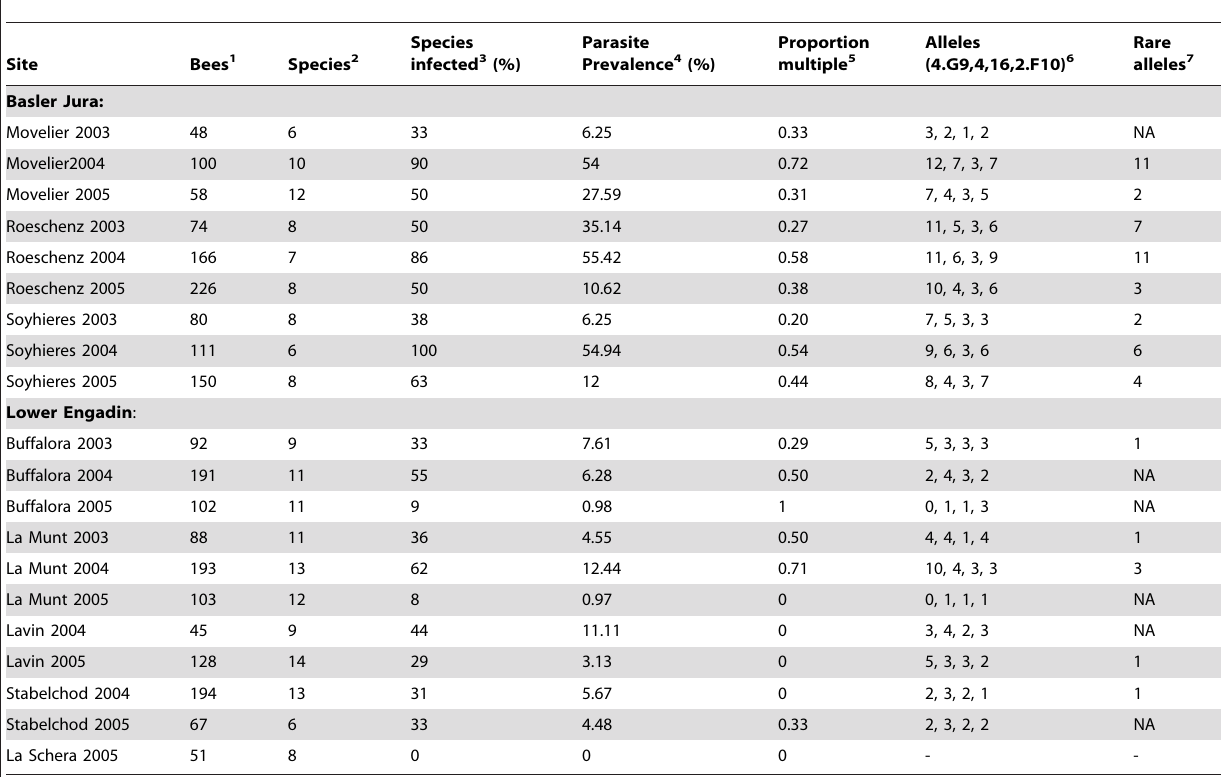
Table 1. Synopsis of sampling data and typed microsatellite alleles for each site and year.